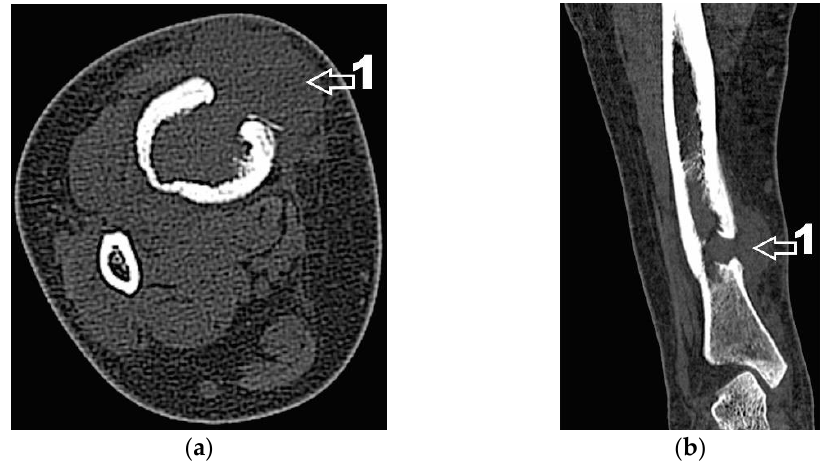
bone cortex, 2 — periosteal reaction.